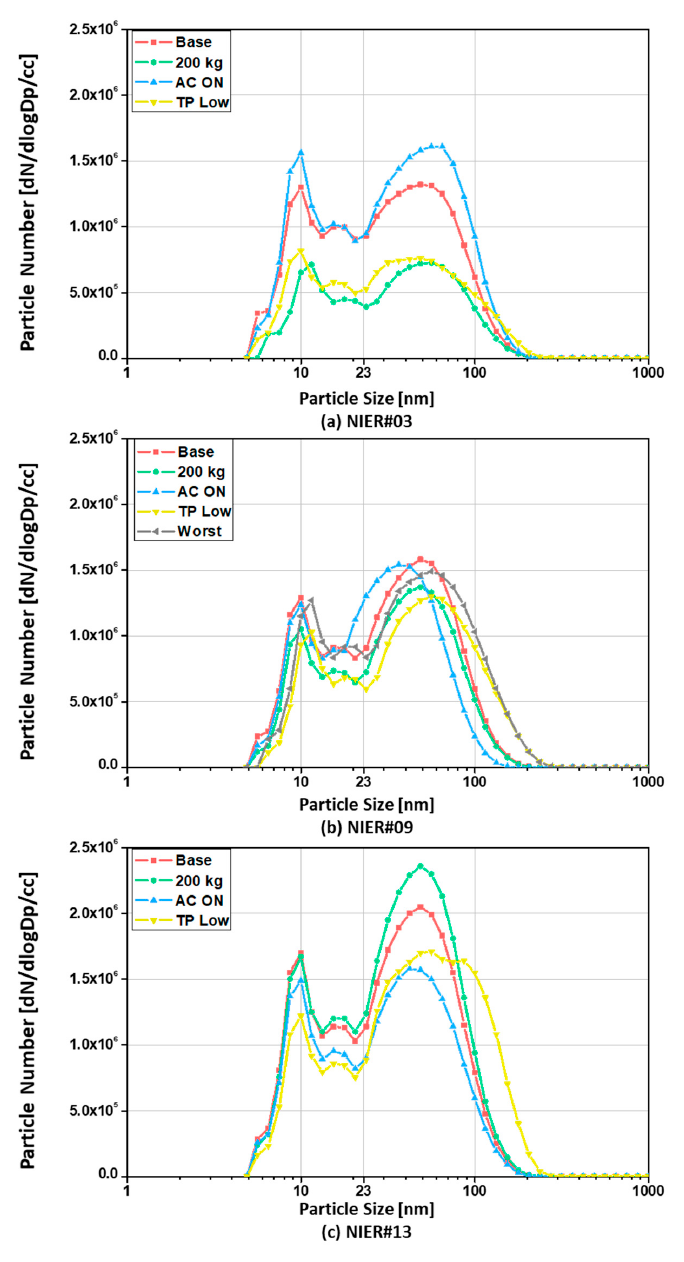
Figure 4. Size-resolved particle number (PN) concentration under National Institute of Environmental Research (NIER) testing modes.